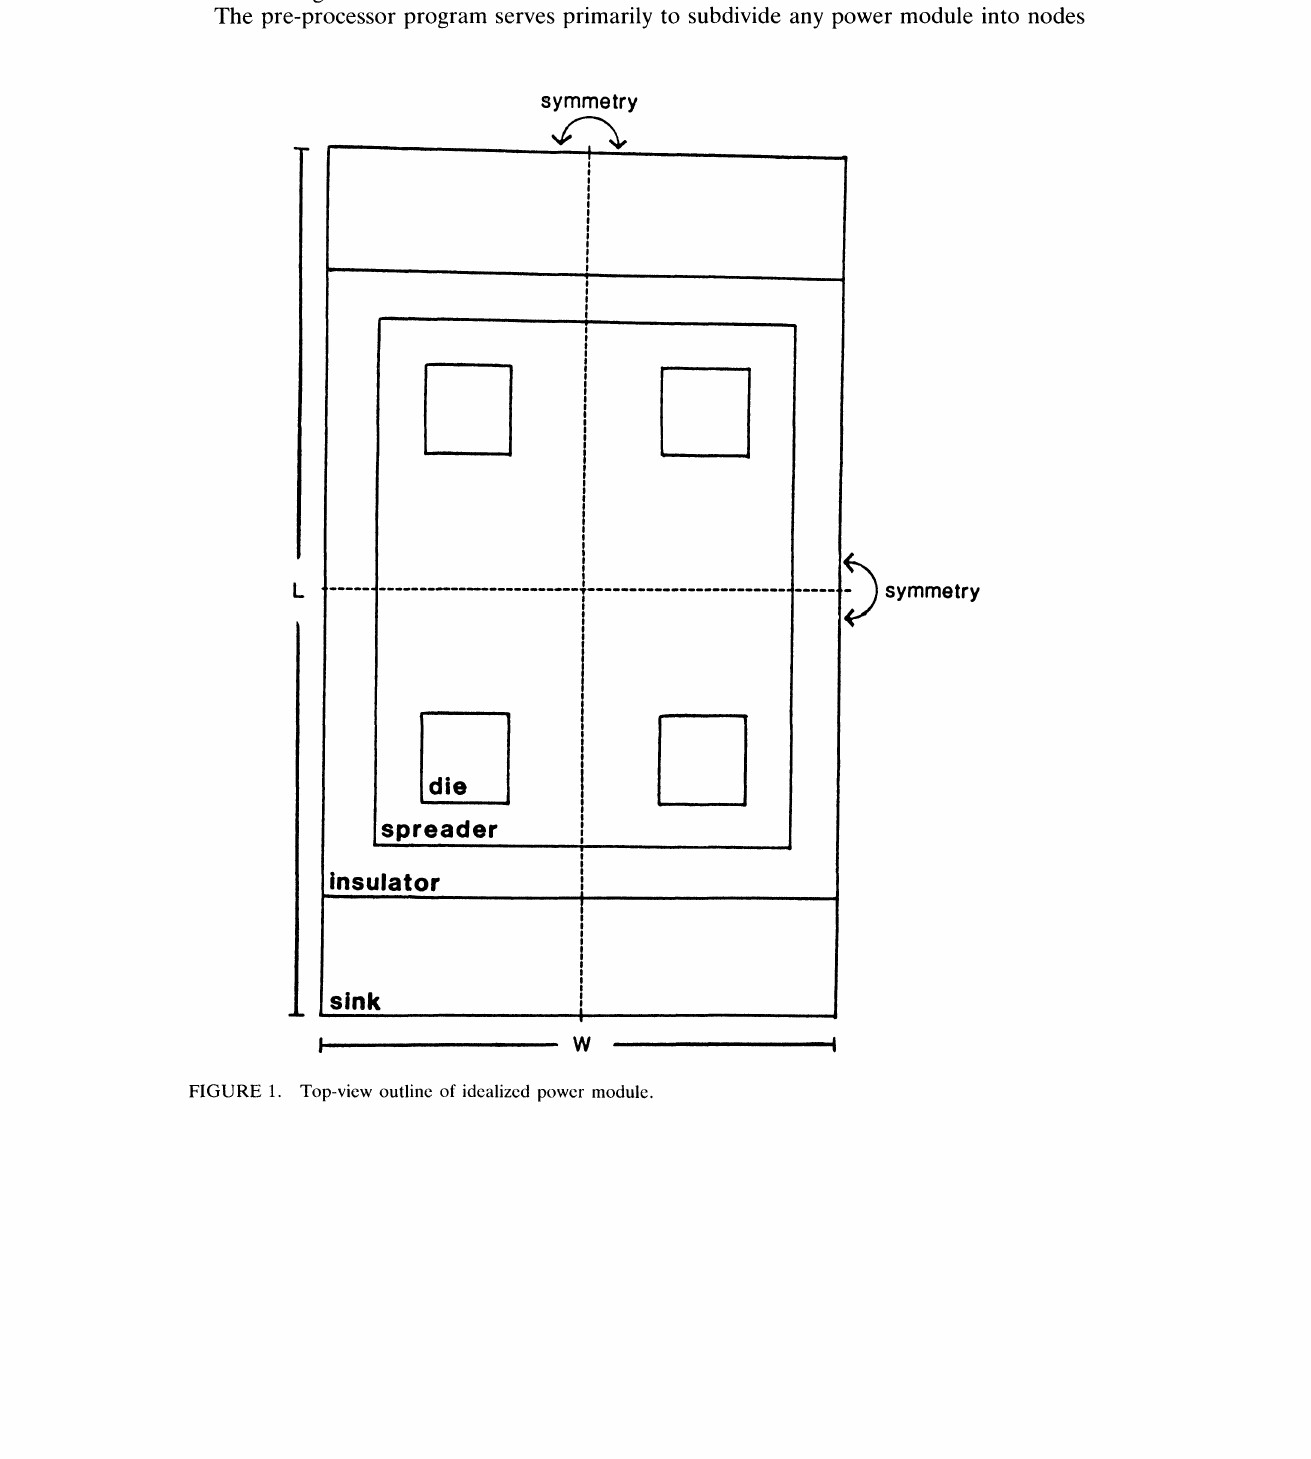
FIGURE 1. Top-view outline of idealized power